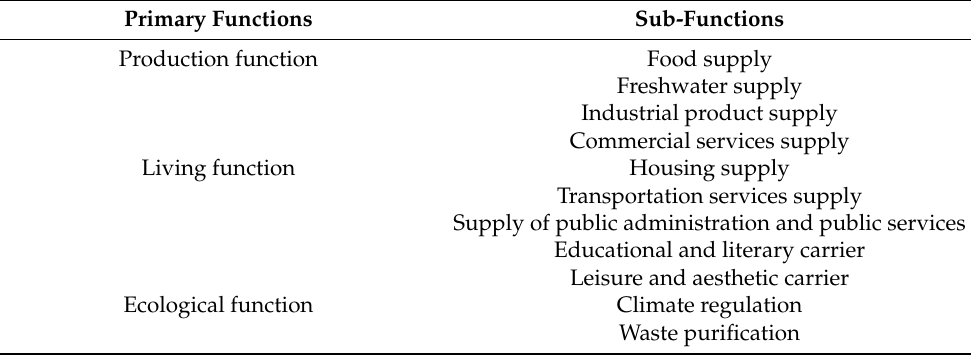
Table 2. Land resources carriers.